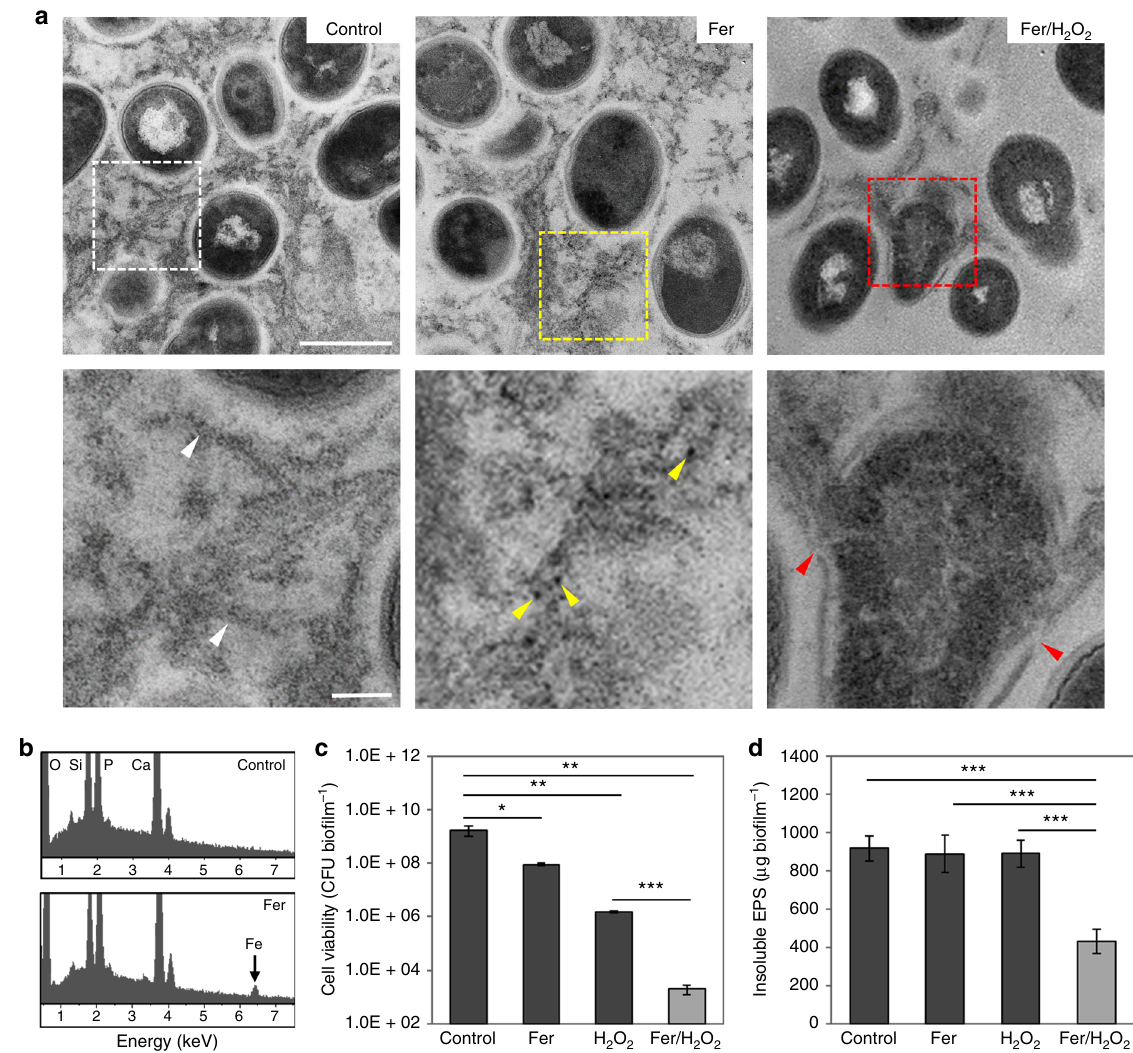
Fig. 4 Antibio fi lm performance of ferumoxytol/H 2 O 2 . a High resolution/magni fi cation TEM images of untreated bio fi lm ultra-structure where bacterial cells can be seen embedded in EPS matrix (white box and white arrowheads); Ferumoxytol bound within bio fi lm (yellow box): higher magni fi cation image shows electron-dense nanoparticles (yellow arrowheads) bound to EPS matrix; TEM of EPS degradation and bacterial morphological damage (red box and red arrowheads) (Scale bars: 500 nm for upper panel and 100 nm for lower panel). b EDS spectra of untreated and ferumoxytol-treated bio fi lms; c Effect on the viability of S. mutans cells within bio fi lms as well as EPS degradation ( d ) following exposure to ferumoxytol and/or H 2 O 2 . The data are presented as the mean ± s.d. from three independent experiments ( n = 6). The quantitative data were subjected to Student ’ s t test for a pairwise comparison. * P < 0.05, ** P < 0.01, *** P <